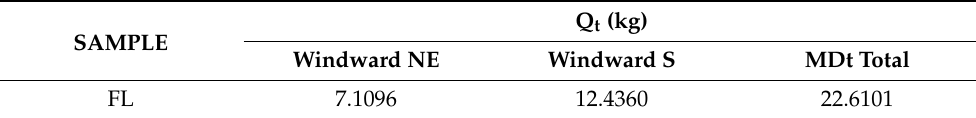
Table 5. Results of total mass transport (Qt).